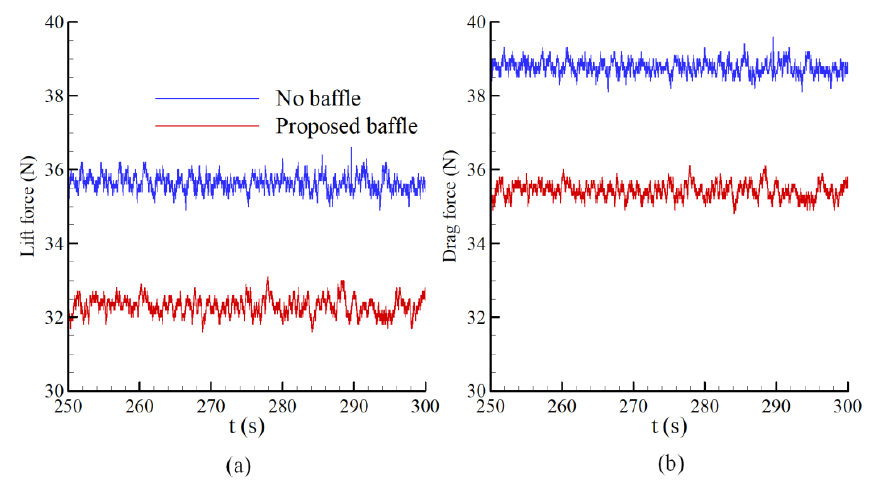
Figure 11. Time variations of (a) lift forces acting on the gate lip and (b) drag forces acting on the downstream face of the gate.